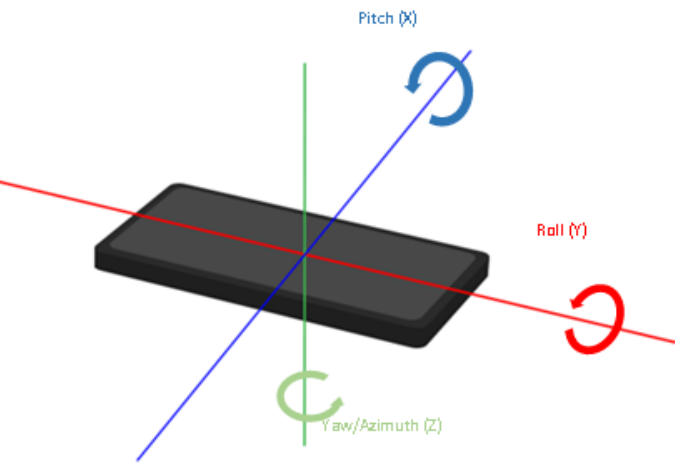
Figure 13. Device rotation